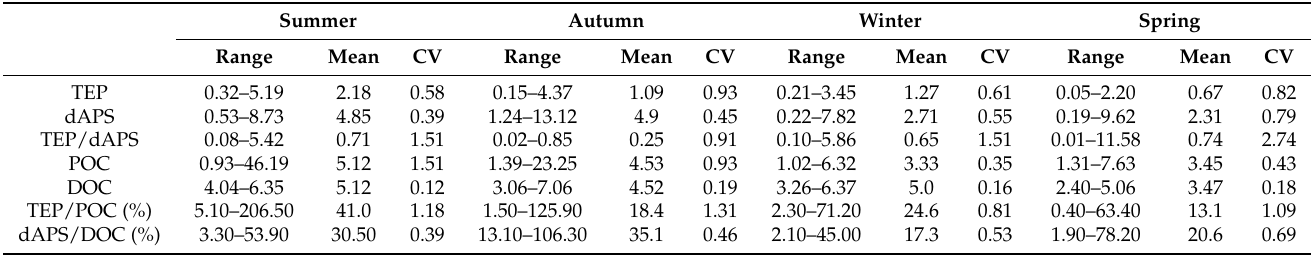
Table 2. Concentration range and mean values of transparent exopolymer particles (TEP), dissolved acidic polysaccharides (dAPS), particulate organic carbon (POC), and dissolved organic carbon (DOC) in Lake